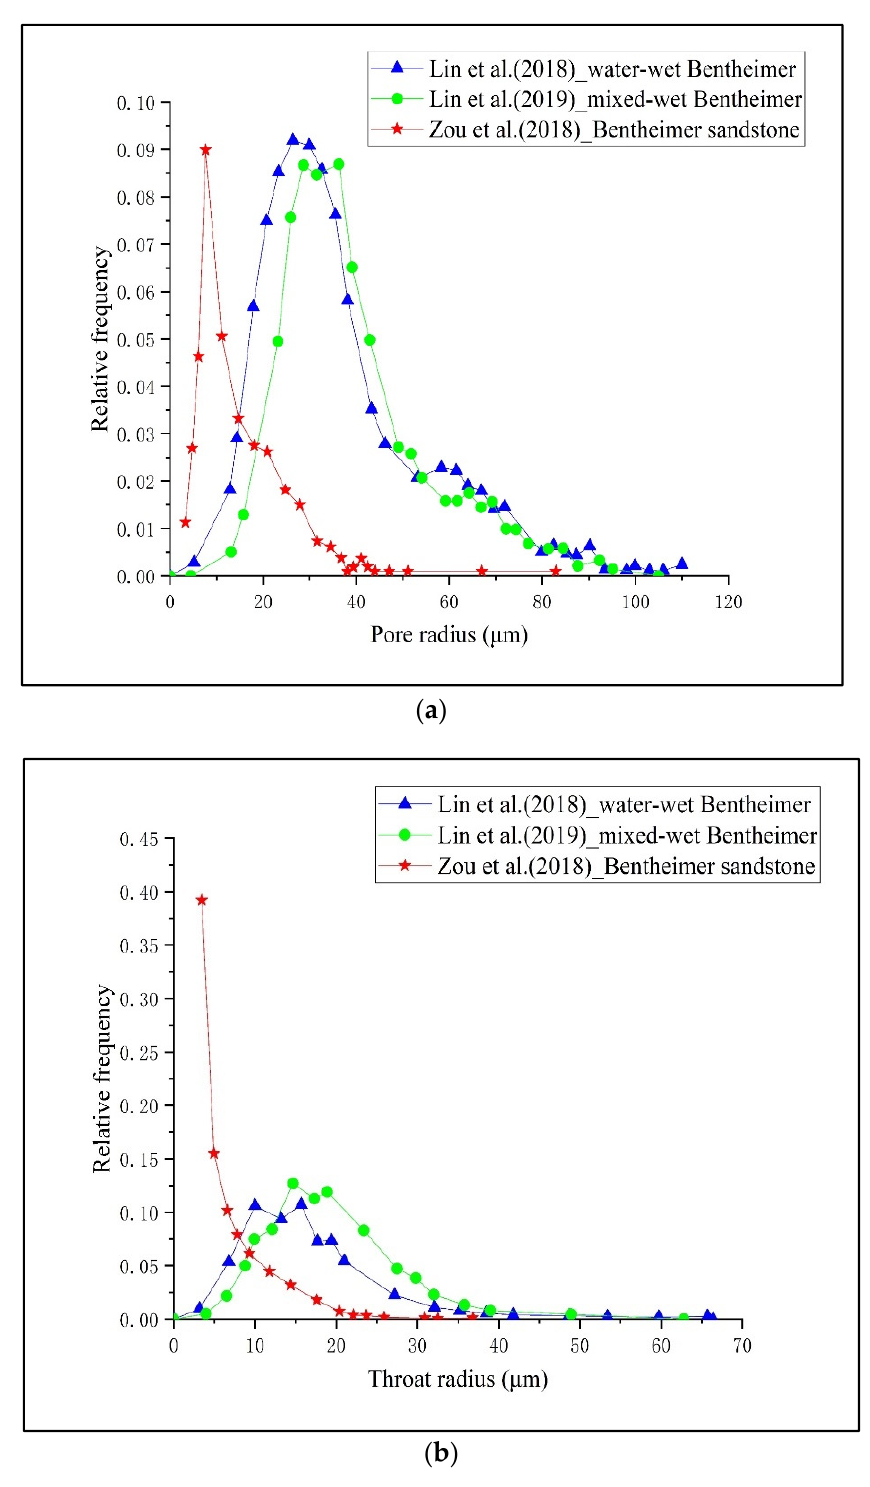
Figure 2. Histogram plot showing the distribution of pores radius ( a ) and throats radius ( b ) for Bentheimer rock used in [15,41,42].